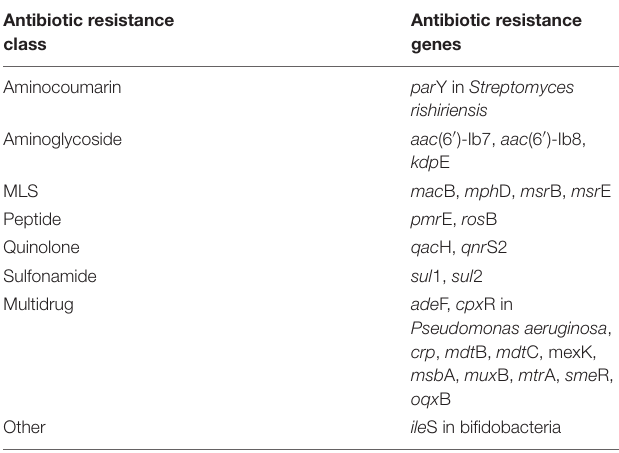
TABLE 2 | Top 25 most abundant core secondary effluent ARGs (detected in all sampling events), based on mean relative abundance, that were also detected in the influent core resistome determined by metagenomics.